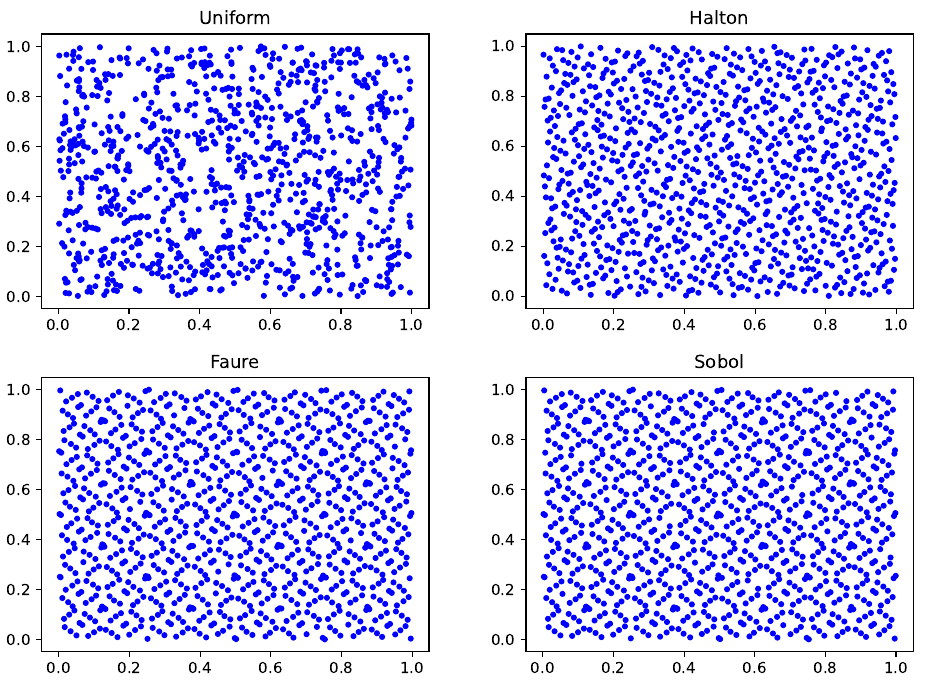
Figure 1. Two-dimensional distribution of pseudo-random and three low discrepancy